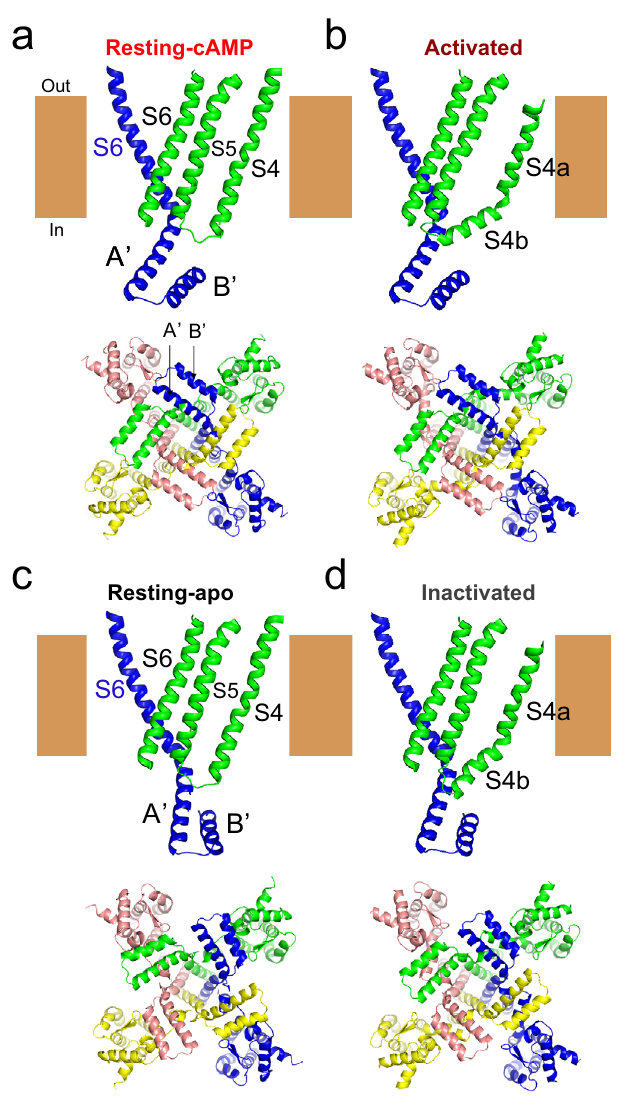
Fig. 6 Rosetta models for activation and inactivation of spHCN channels and their regulation by cAMP. a – d Modeled structures (side view and bottom view) highlighting the rearrangement of the C-linker region of one subunit relative to the S4 and S5 helices of the adjacent subunit for four states: resting-cAMP ( a ), activated ( b ), resting-apo ( c ), and inactivated ( d ). The S4 helix moves downward and bends into two segments after hyperpolarization in both activated and inactivated states. The bottom view highlights the rigid-body rotational movements of the C-linker around the central axis of the pore in the absence of cyclic nucleotide. See also Supplementary Movies 1 – The conformational rearrangements between the resting-apo and inactivated models showed features distinct from those in the presence of cAMP (Fig. 6, Supplementary Fig. 8, and Supple- mentary Movie 4). Unlike the models in the presence of cAMP, the inactivated model displayed a considerable rotation of the C- linker relative to the resting-apo model (compare Supplementary Movies 3 and 4). The rotation appears to result from an interaction between the carboxy-terminal region of the S4 helix and the A ′ helix, causing the downward and tilting motion of the S4 to be translated into a rotation of the C-linker (Supplementary Movie 4). The counterclockwise rotation of the C-linker at − 100 mV in the absence of cyclic nucleotide is in the direction expected